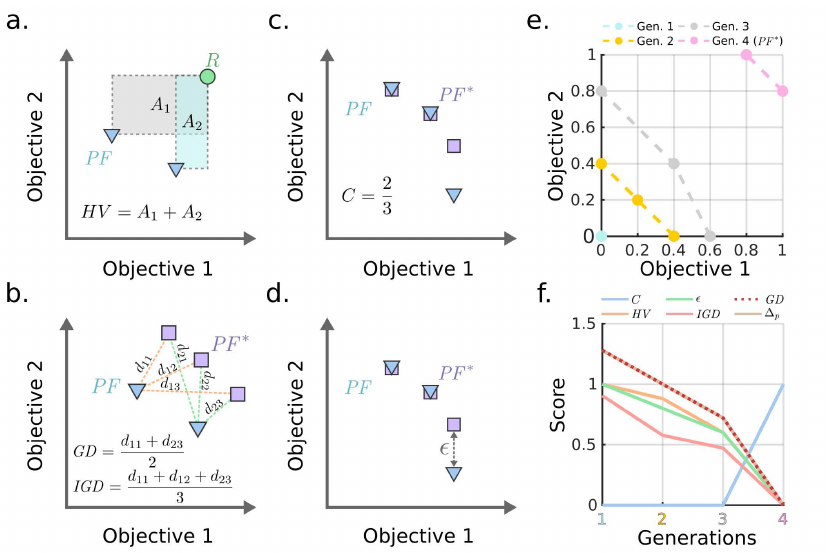
Figure 1. ( a – d ) Conceptual illustration of performance metrics of MOEAs for a two-objectives design problem. PF and PF ∗ correspond to the Pareto front approximation and the best Pareto front available, respectively. The reference point R must always dominate all solutions in PF . ( e – f ) An example of Pareto fronts with 2 dimensions and associated metrics. The 4th generation corresponds to PF ∗ used as a reference for